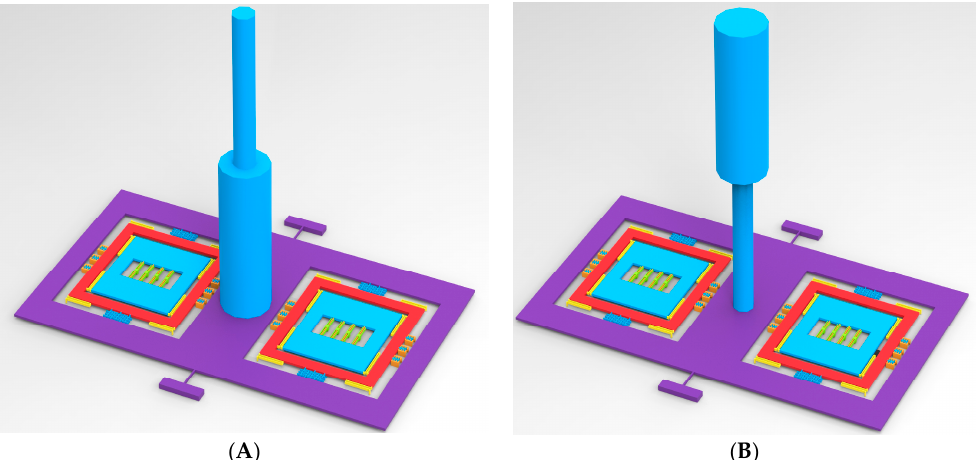
Figure 6. Hair post structures with different center of gravity for acceleration sensitive optimization. ( A ) I-shape hair post; ( B ) II-shape hair post.